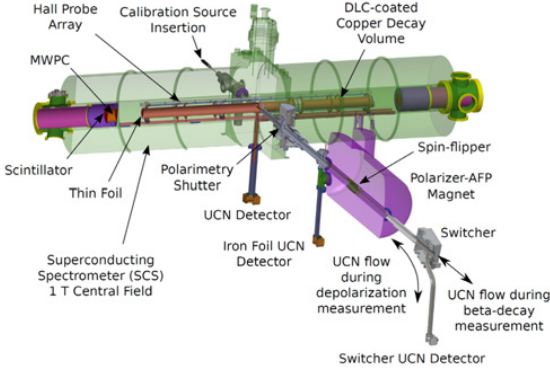
Figure 1. Schematic diagram showing the primary components of the UCNA experiment, including the 7 T polarizing magnet, the spin flipper, the electron spectrometer, and the UCN detector at the switcher (used for polarization